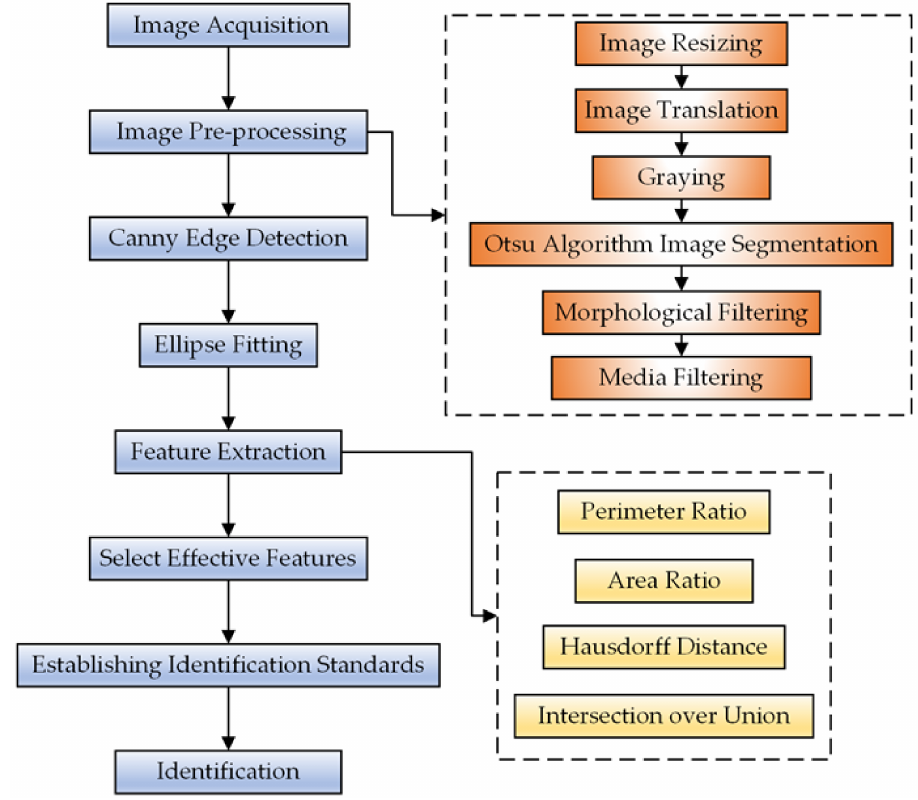
Figure 3. Flow chart of the irregular potato identification